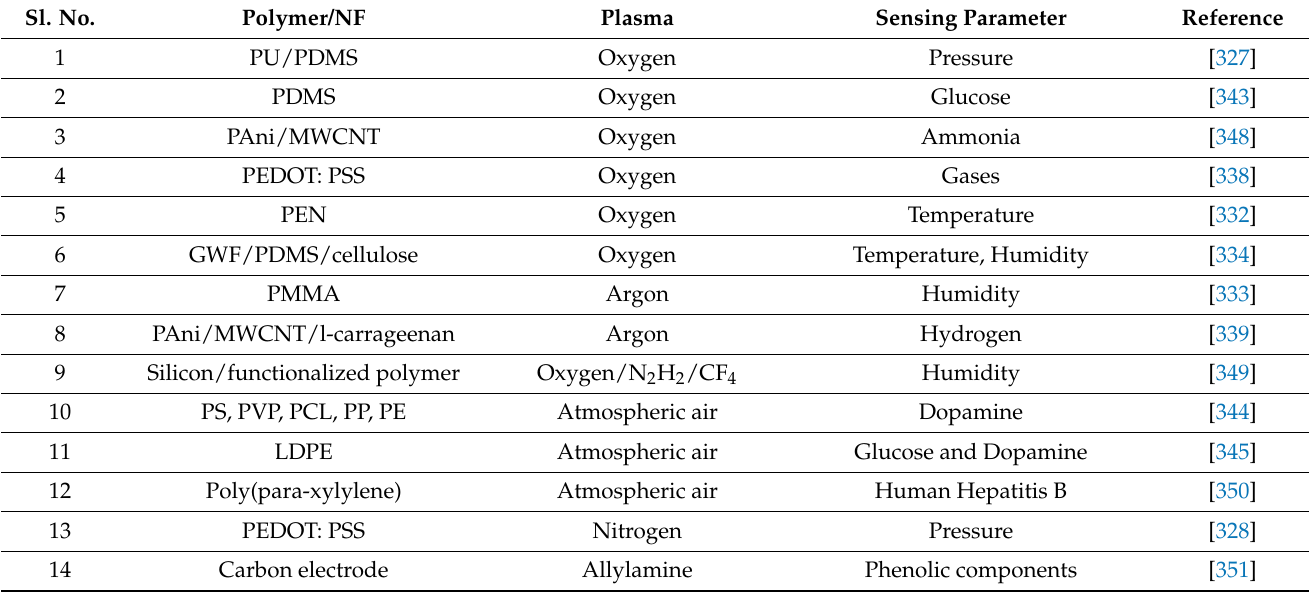
Table 8. Reported some studies of plasma-treated polymers for sensing